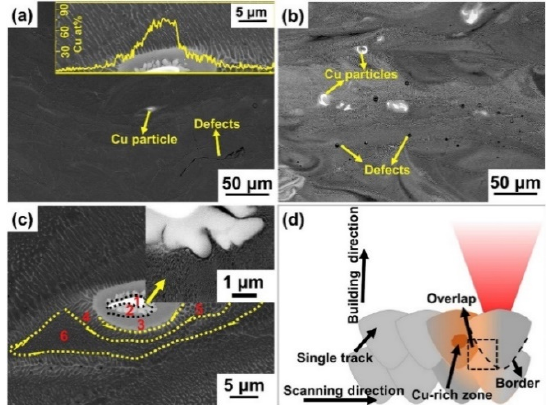
Figure 14. BSE-SEM micrographs of SLM Al-xCu alloys: ( a ) 6Cu alloy (inset: Cu distribution across the Cu-rich zone); ( b ) 40Cu alloy; ( c ) Cu-rich zone in the 6Cu alloy (inset: high magnification). ( d ) Schematic illustrating the diffusion of Cu during SLM processing [115]. Copyright 2017. Adapted with permission from Elsevier Science Ltd. under the license number 4803700463746 (Figure 2 [115]),